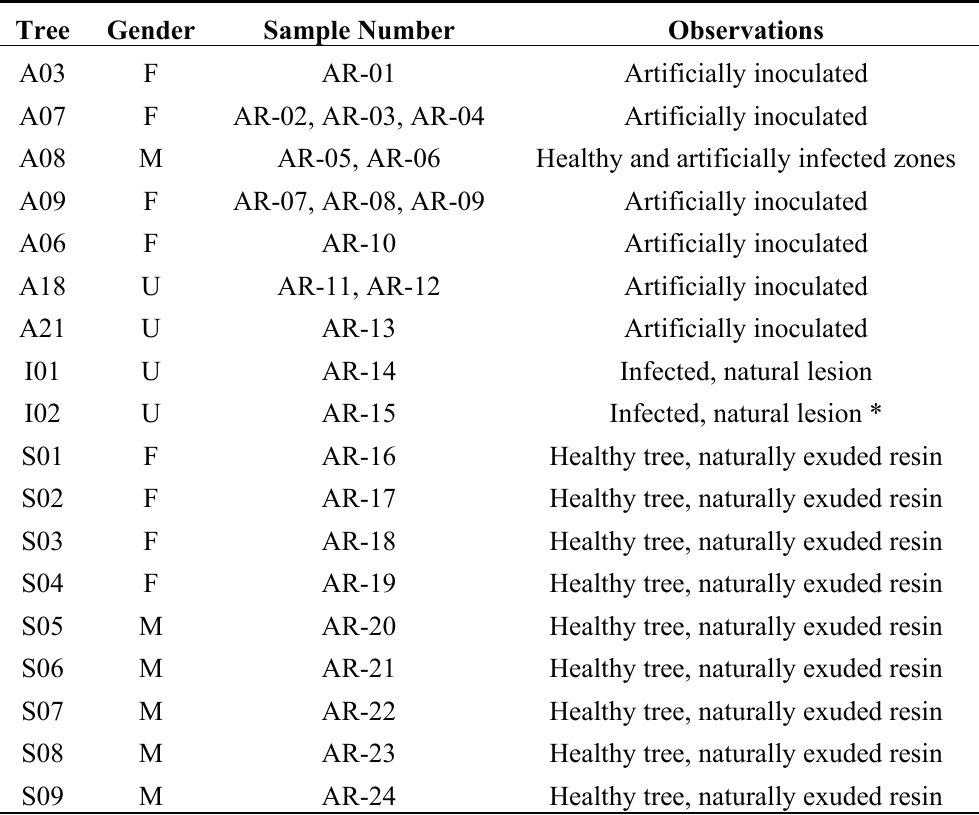
Table 1. Resin sample collection (November, 2011). Río Grande Valley, Parque Nacional Los Alerces, Provincia del Chubut, Argentina. F: Female, M: Male, U: Unknown. Tree Gender Sample